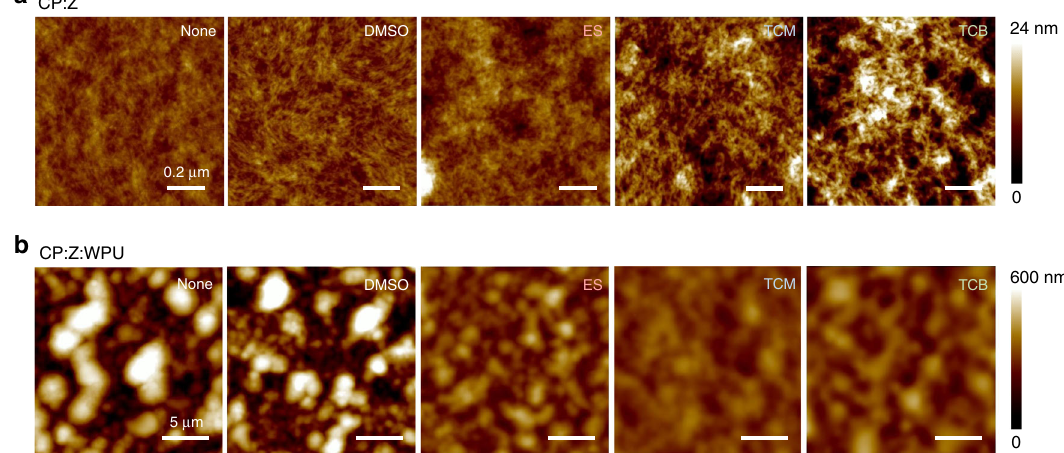
Fig. 5 Morphological changes induced by the addition of IL. AFM height images of a CP and b CP-WPU composite fi lms, both with and without a different type of ILs or DMSO (Z). The CP fi lms with ILs were washed with water before the measurements to remove excess IL on the surface. The images of CP- WPU composite fi lms were measured on as-prepared samples, without washing. Scale bars, a 0.2 μ m, b 5 μ